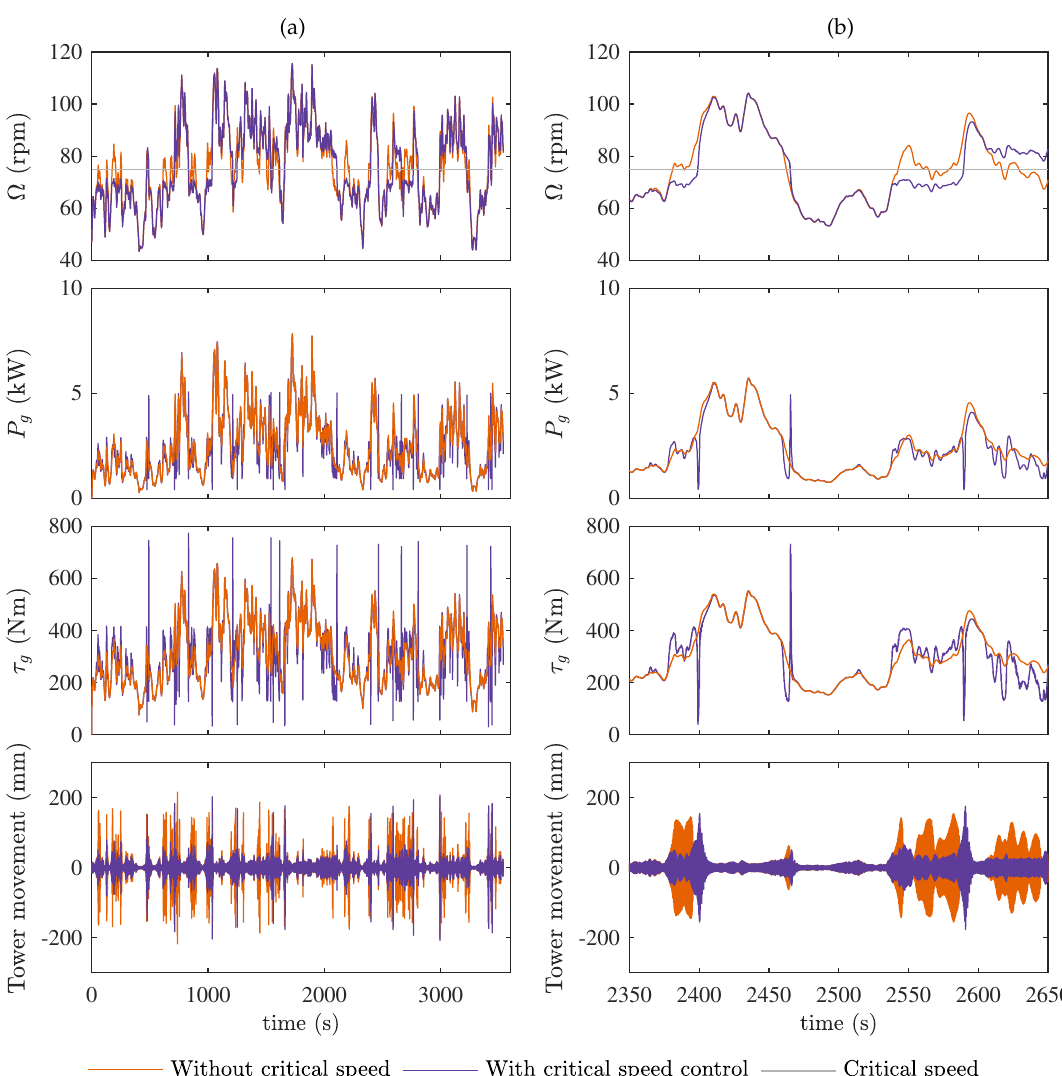
Figure 8. Simulation with and without the critical controller activated, showing the 60-min run in ( a ) and a 5-min extraction in ( b ). The optimal rotational speed for the average of the wind speed is at 75rpm, which is also the critical speed for exciting the tower. A total of 23 skips was performed during the 60 min, of which three skips are occurring in ( b